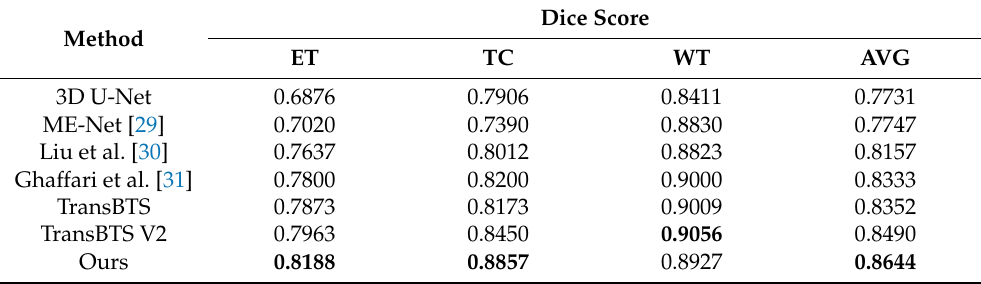
Table 3. Quantitative comparisons of segmentation performance in brain tumour segmentation tasks of the BraTS dataset. WT, ET and TC denote Whole Tumour, Enhancing Tumour and Tumour Core subregions, respectively.